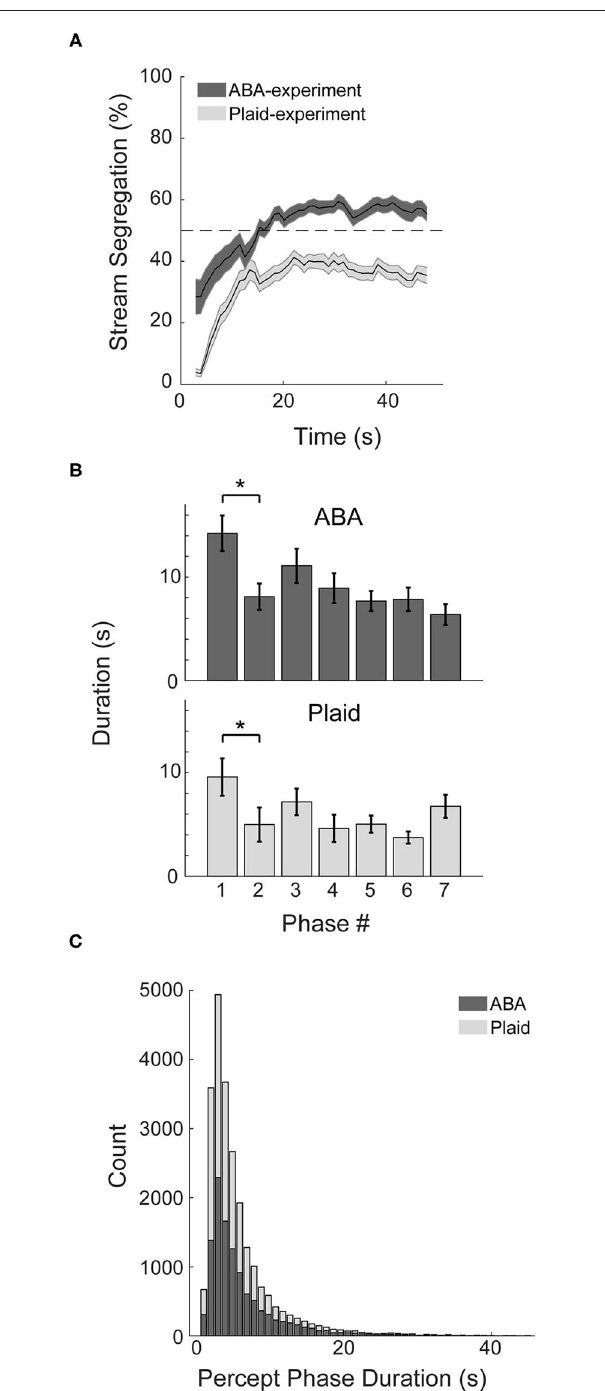
FIGURE 2 | Characteristics of response patterns. (A) Percentage of stream segregation reported across the 48s of a stimulus trial averaged across participants for the auditory ABA (dark gray) and visual Plaid (light gray) paradigms. Error bars correspond to SEM. (B) Duration of the first seven perceptual phases in sequence, averaged across subjects for each experiment. (C) Distribution of phase durations across both experiments. * p <